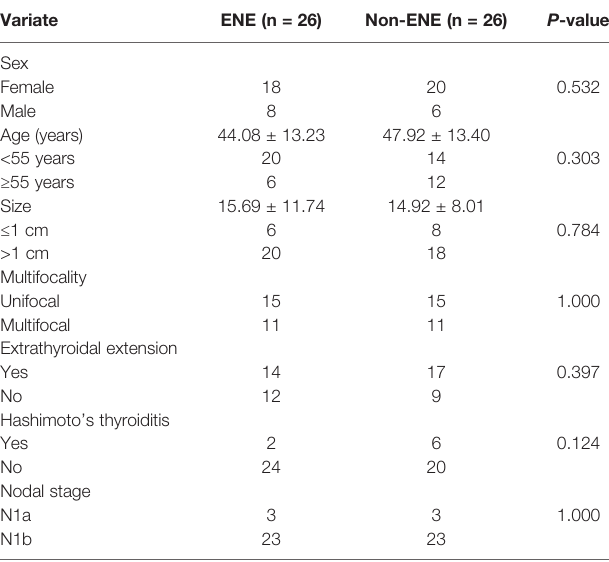
ENE, extranodal extension; PSM, propensity score matching.